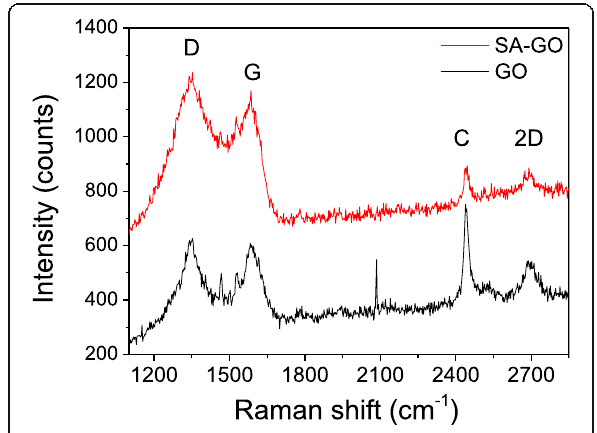
Fig. 6 The typical Raman spectrum of SA-GO (which is prepared by the reactions of octadecylamine and the sulfur-doped graphene oxide; the oxidation time of the graphene oxide is 24 h) and GO (the oxidation time of the graphene oxide is 24